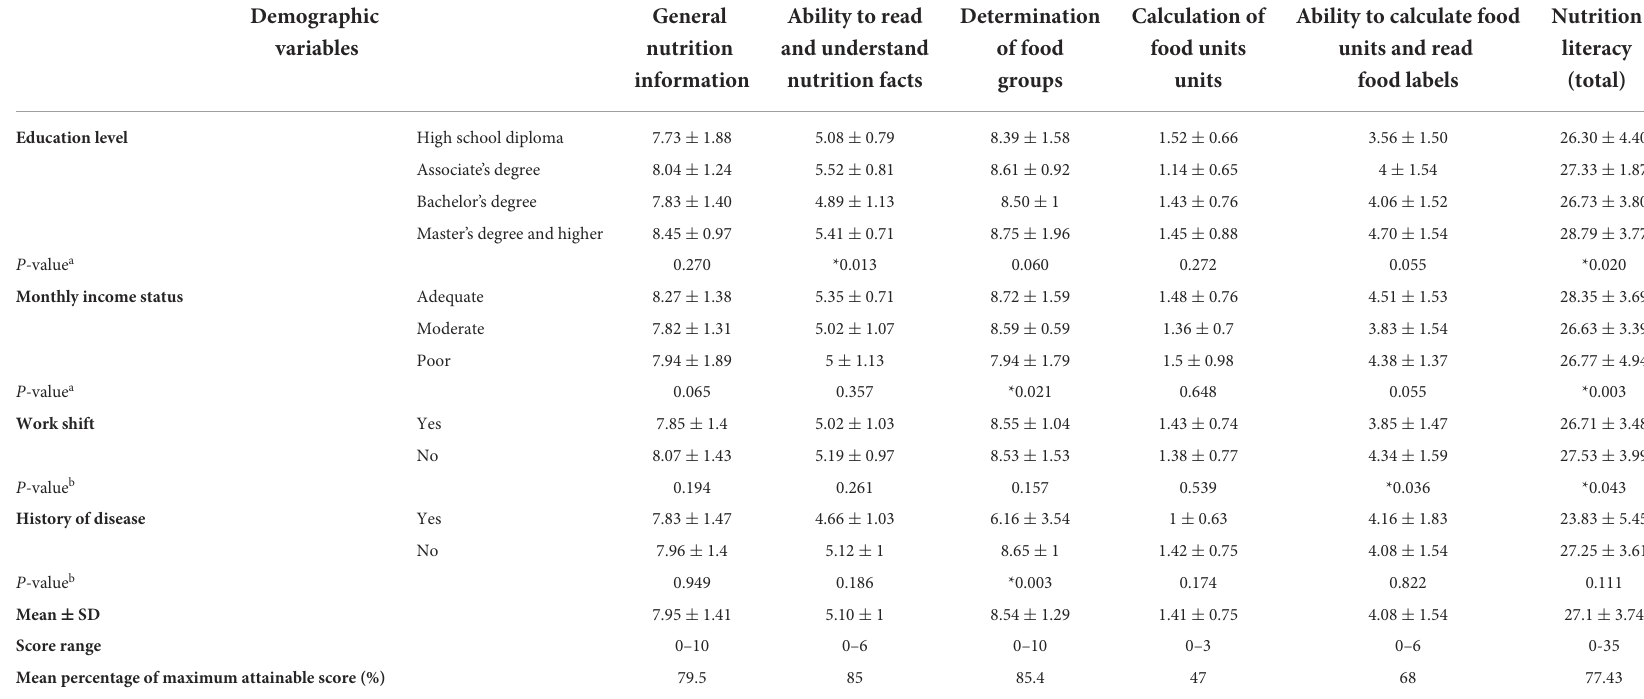
TABLE 2 Comparison of average nutrition literacy and its dimensions in workers by demographic